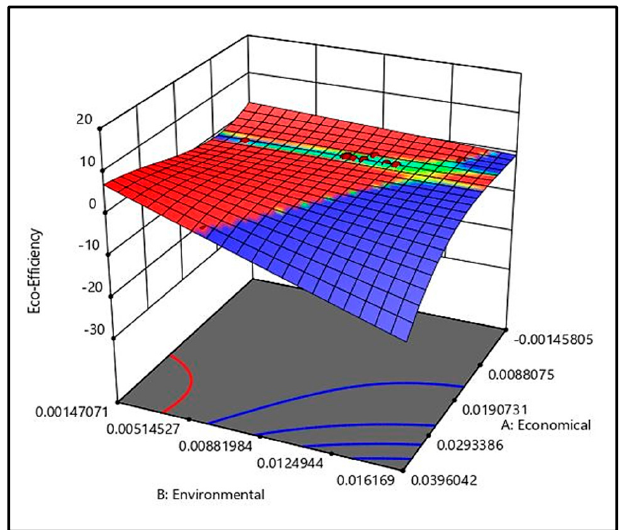
Figure 18. Response surface graph of blast furnace slag based concrete used for double story houses.